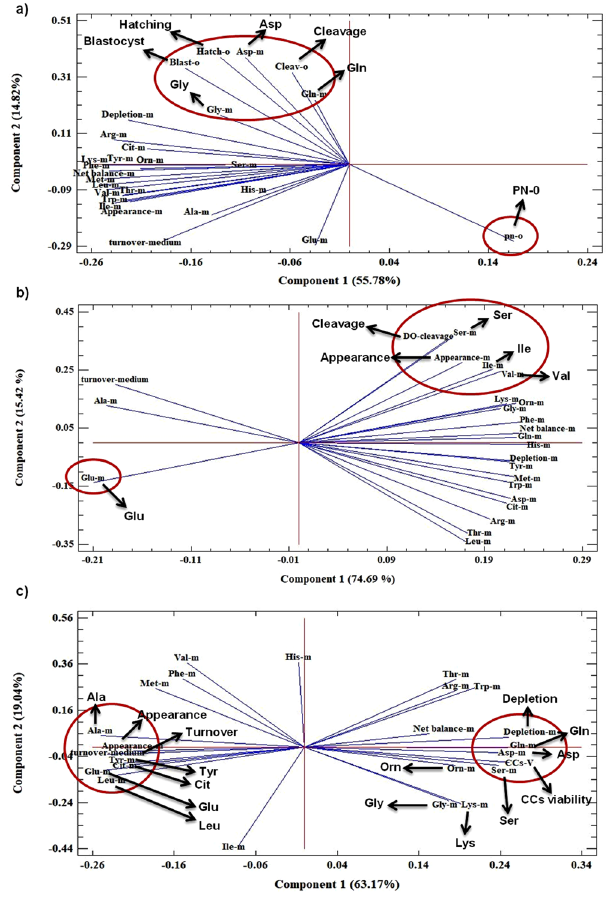
Figure 7. Biplot of PCA derived from the amino acid turnover and developmental competence of COCs ( a ), cleavage rate of DOs ( b ), and cell viability of CCs ( c ). Vectors with close angles ( < 45°) indicate a strong correlation, vectors that are perpendicular indicate no correlation, and vectors in opposite directions (approaching 180°) indicate a negative